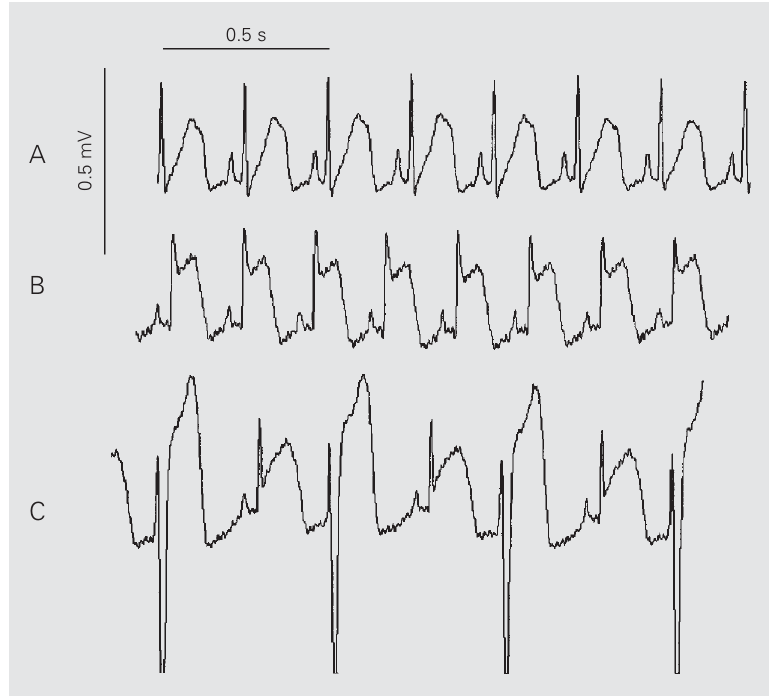
Figure 2. Representative examples of the changes in ECG lead II tracings induced by the central injection of L-glutamate (10 µmol, icv ) in one N (cid:2) -nitro-L-arginine methyl ester (L- NAME, 40 mg/kg, iv )-treated pentobarbital-anesthetized rabbit. A , Initial ECG. B , ST-seg- ment shift. C , Premature ventricular complexes, after injection of L-NAME (40 mg/kg, iv ) followed by L-glutamate (10 µmol, icv ). These typical ECG recordings are representative of those obtained for 18 rabbits (control